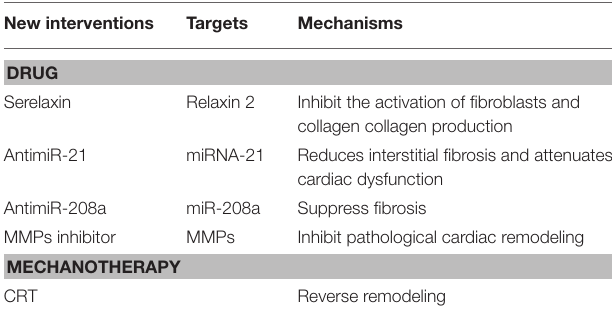
TABLE 2 | New interventions and their targets of myocardial